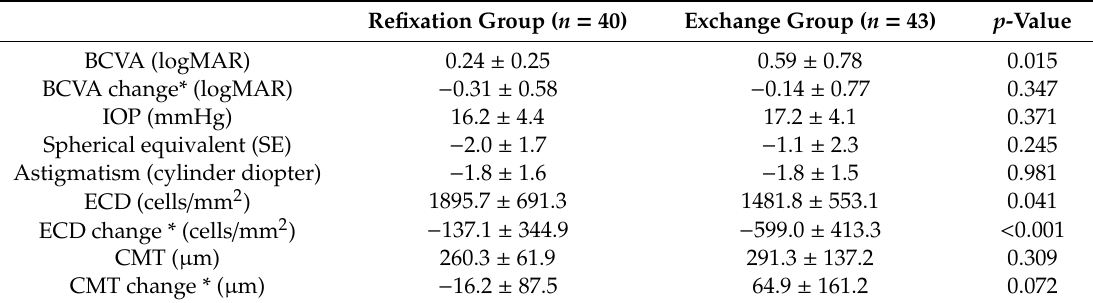
Table 2. Treatment Outcomes at 6 months after